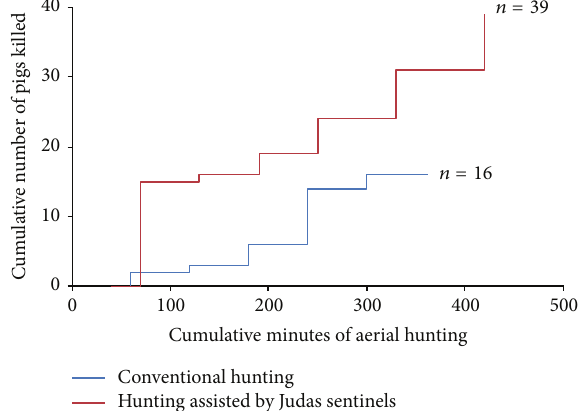
Figure 4: Comparison of killing rates for pigs, from six aerial hunt- ing sessions on Molesworth Station when hunting conventionally or using radio-collared released “Judas” pigs to assist location of mobs. Assisted aerial hunting accounted for 39 pigs (31 resident wild animals and 8 purpose-released “Judas” animals; red line); unassisted hunting accounted for 16 wild pigs (blue